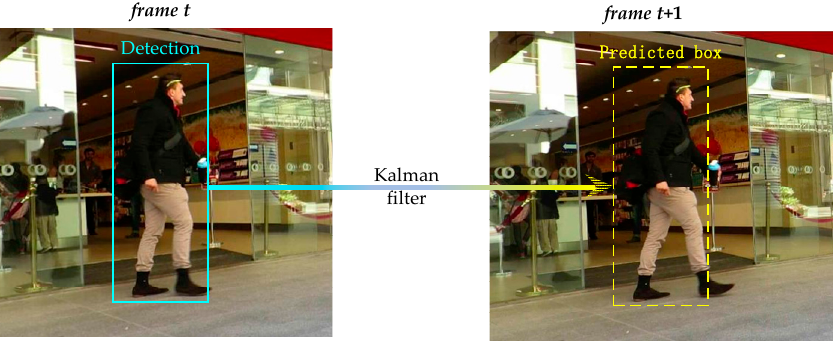
Figure 7. Predicted object location via Kalman filter.